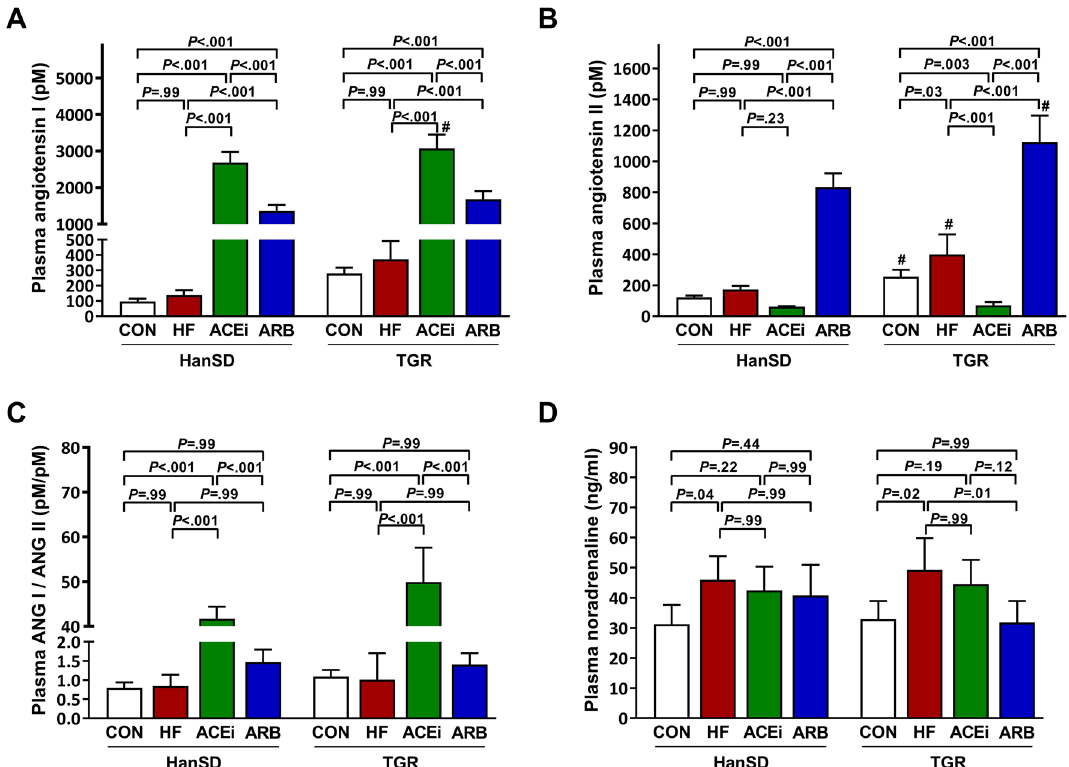
Figure 5. Plasma angiotensin I levels ( A ), plasma angiotensin II levels ( B ), plasma angiotensin I to angiotensin II ratios ( C ) and plasma noradrenaline levels ( D ) of control (CON), untreated heart failure (HF), ACE inhibitor- treated (ACEi) and AT 1 receptor blocker-treated (ARB) HanSD and TGR rats 20 weeks after sham or ACF operation (5 weeks in HF TGR rats due to high mortality). Data presented as mean ± SD (n = 5–6 in each group). # P < 0.05 compared to HanSD